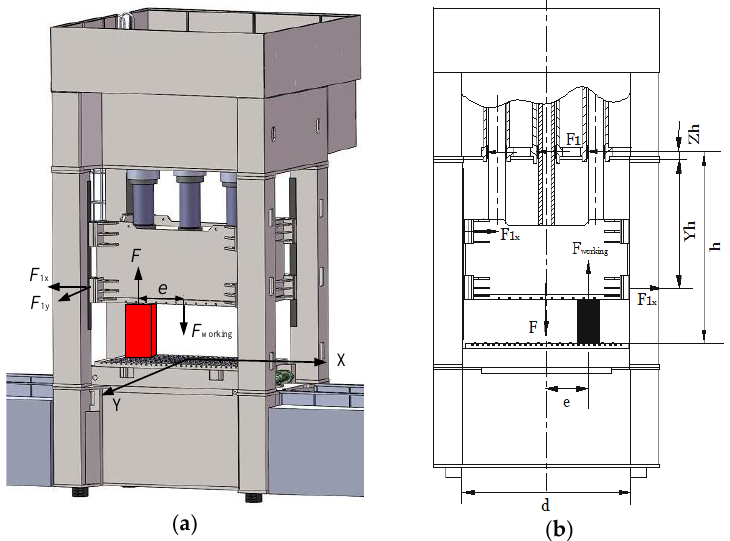
Figure 4. Lateral force analysis: ( a ) eccentric moment acting on the slide, and ( b ) eccentric loads force acting on hydraulic press.